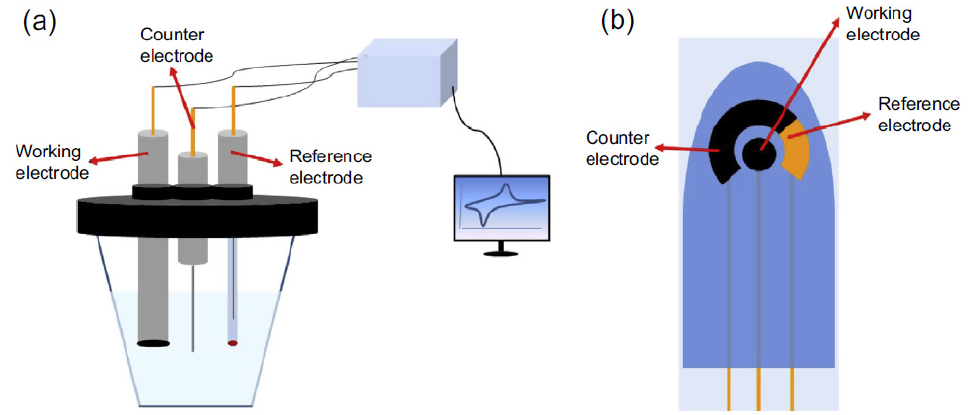
Figure 12. ( a ) An electrochemical working cell, ( b ) disposable screen-printed electrode. Reprinted with permission from Ref. [180]. Copyright 2017, Elsevier.